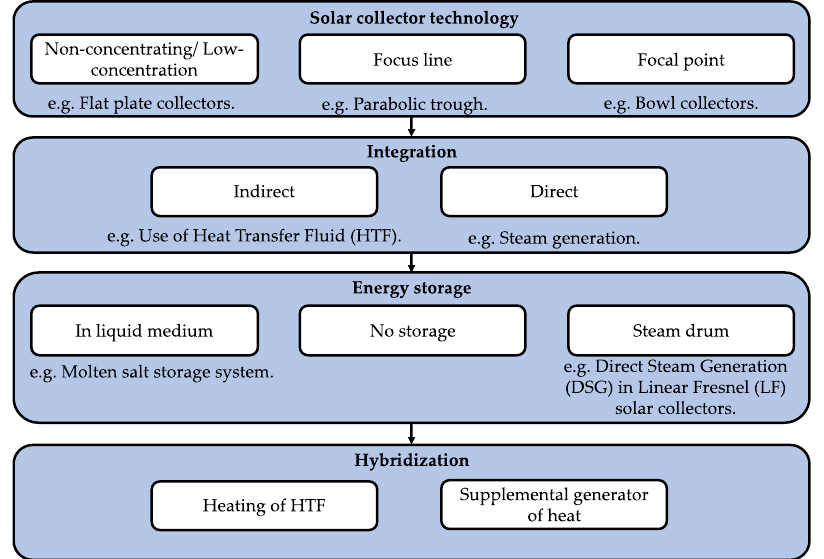
Figure 4. Conceptual diagram depicting the classification of solar collector technologies.